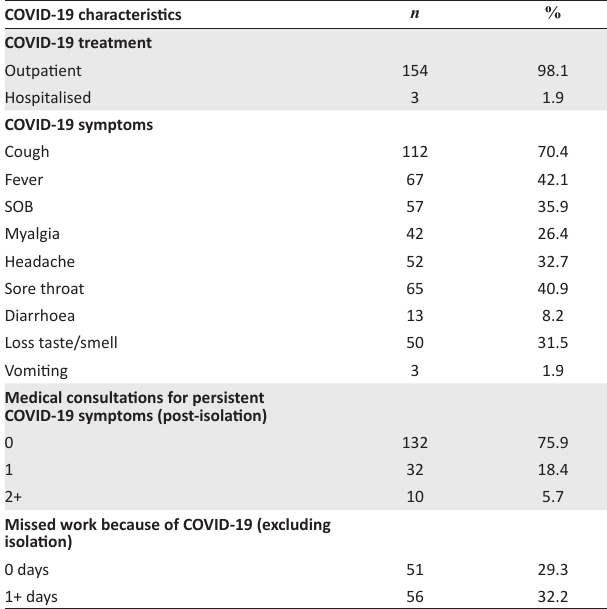
TABLE 2: COVID-19 episode